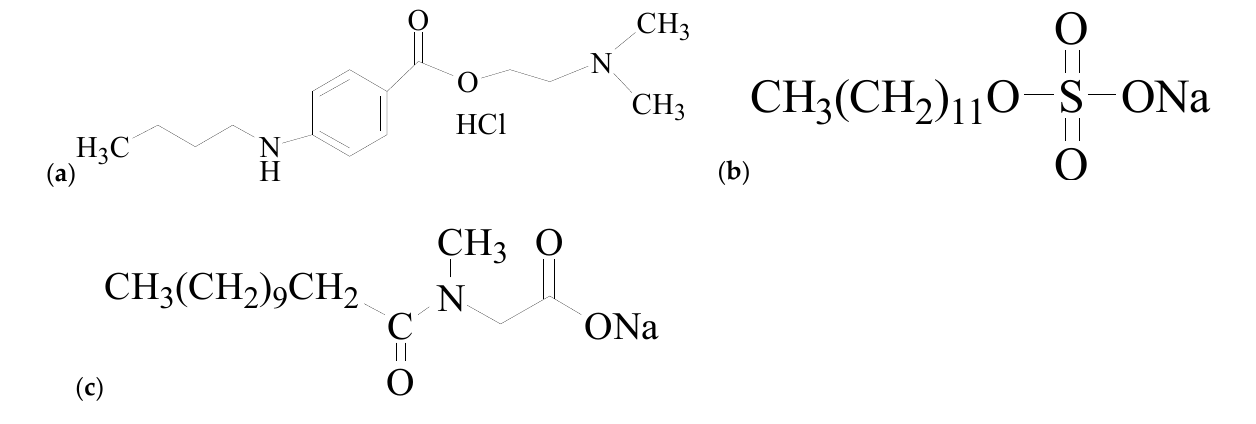
Figure 1. Chemical structures of ( a ) tetracaine hydrochloride (TCH), ( b ) sodium dodecyl sulfate (SDS), and ( c ) sodium lauryl sarcosine (SLS).